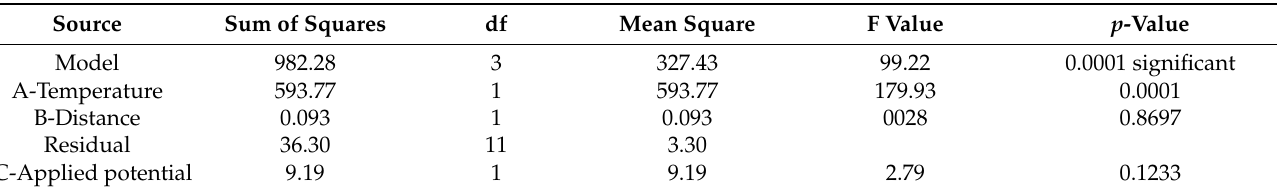
Table 2. ANOVA for response surface reduced quadratic